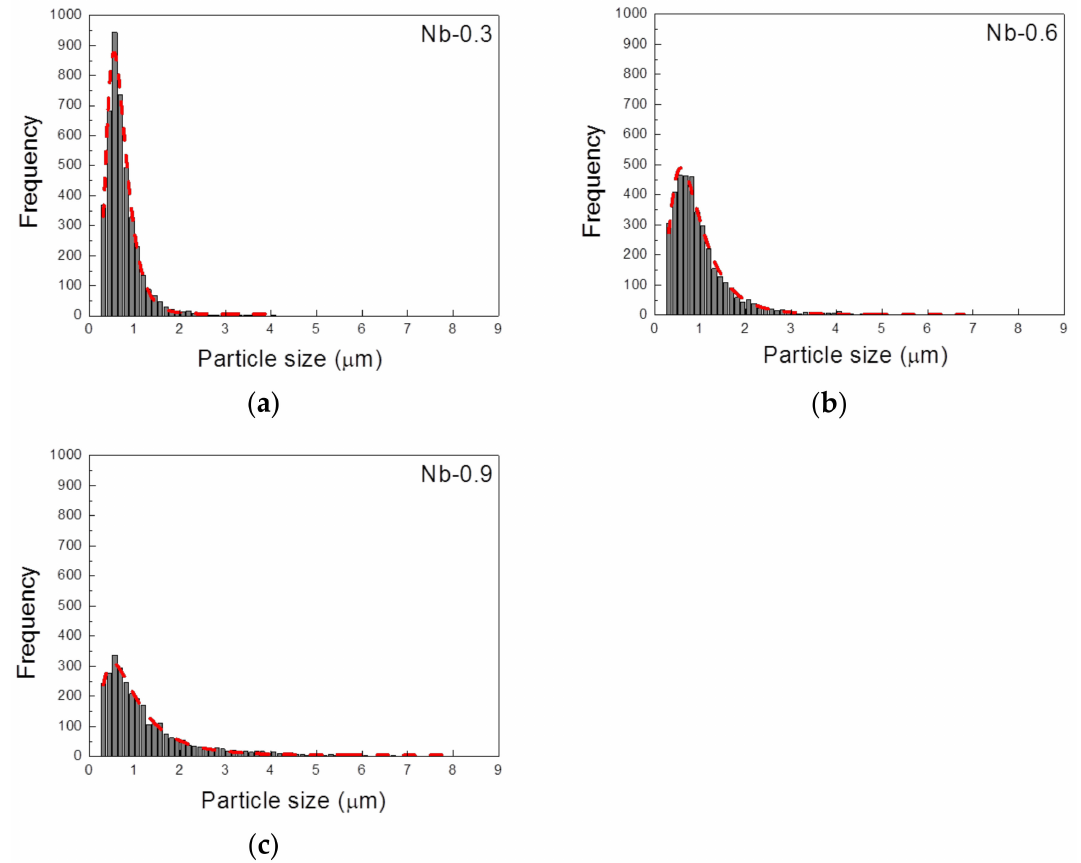
Figure 8. Histograms of precipitate size in the 22Cr25NiWCuCo(Nb) steel specimens with different Nb contents after heat treatment at 1200 ◦ C for 2 h: ( a ) Nb-0.3, ( b ) Nb-0.6, and ( c ) Nb-0.9 steel